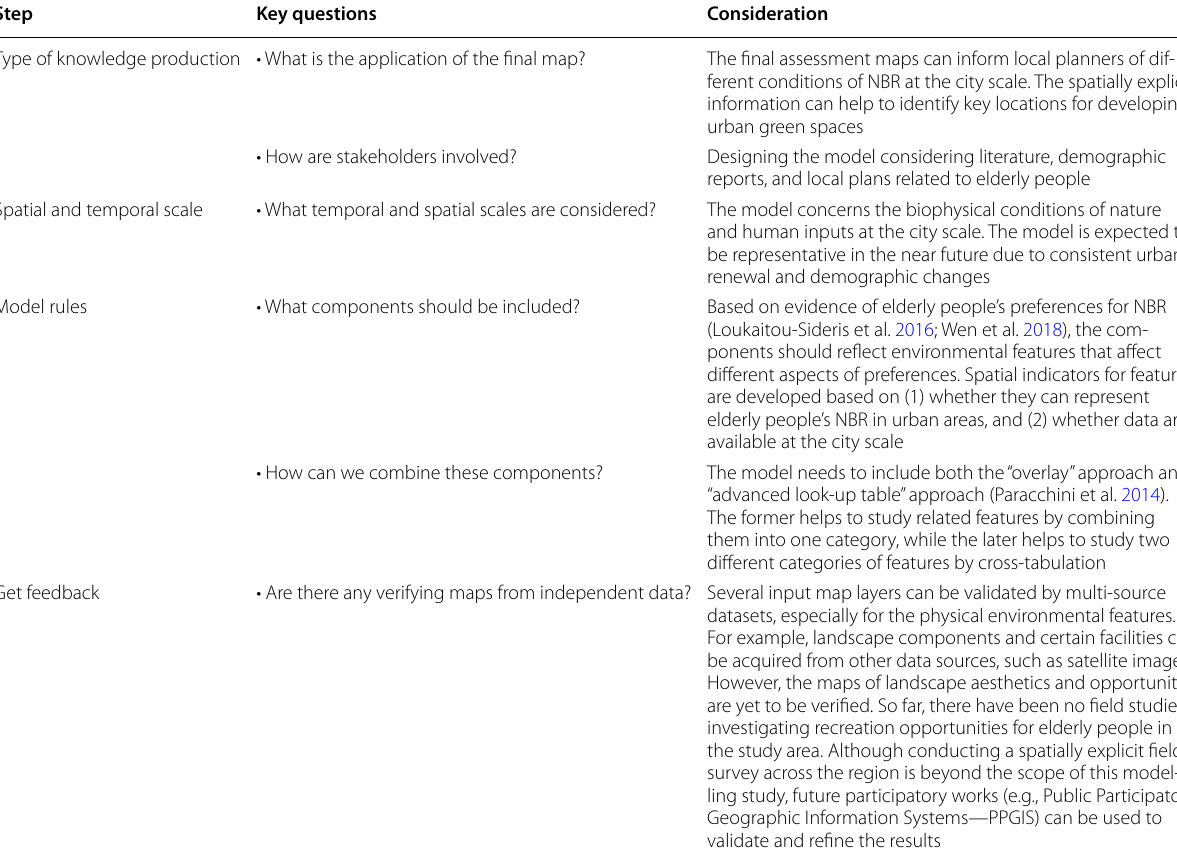
The protocol refines the spatial modelling process by underscoring the importance of local conditions, research purposes, and effectiveness of the analysis The protocol is referenced to Carvalho et al.